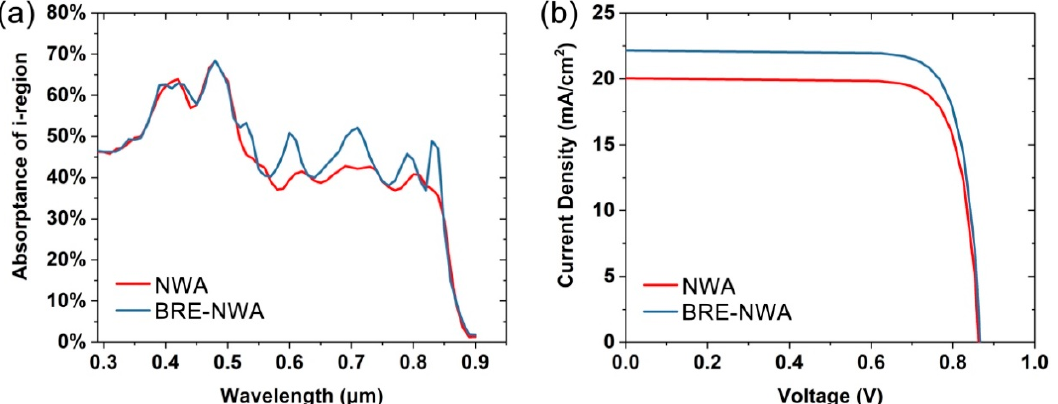
Figure 3. ( a ) Absorption spectra of the i-region and ( b ) current-voltage curves of the NWA and BRE-NWA structures.